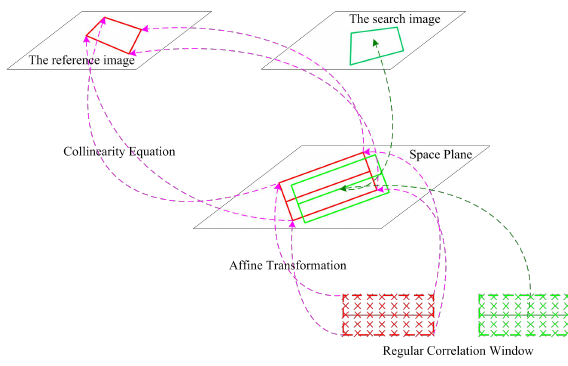
Fig.4 The correction window warping procedure